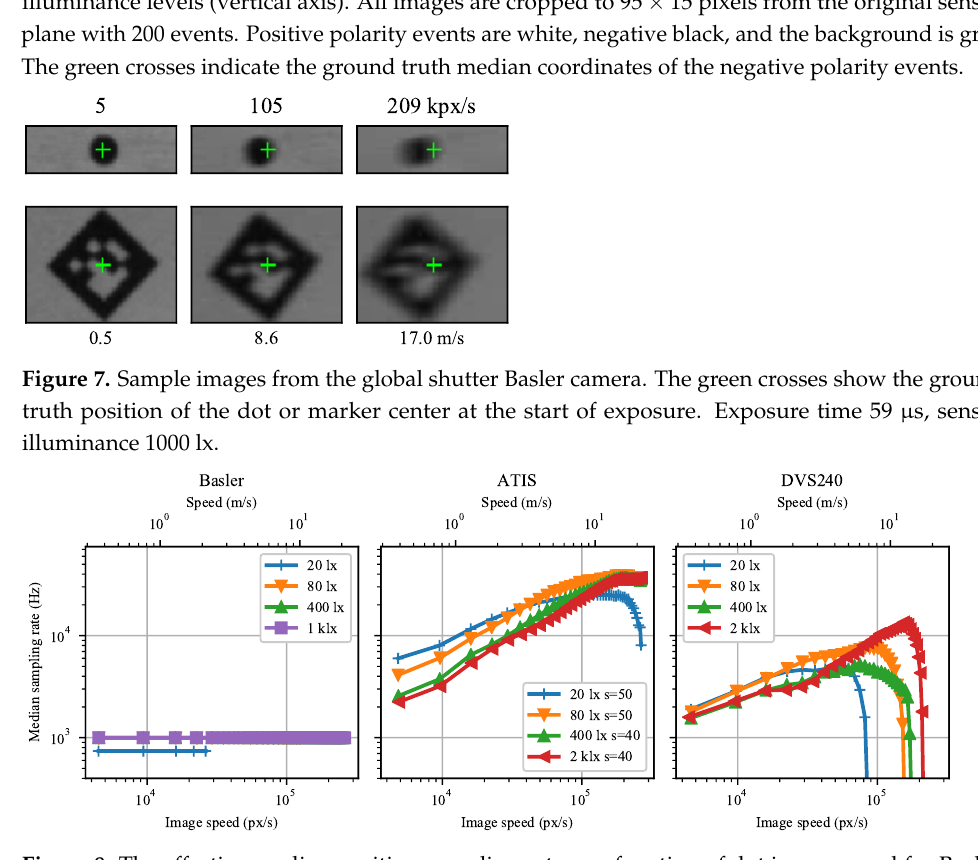
Figure 8. The effective median position sampling rate as a function of dot image speed for Basler, ATIS, and DVS240 cameras when computing each position estimate from 100 negative polarity events. Data were measured for four background scene illuminance levels at the sensor